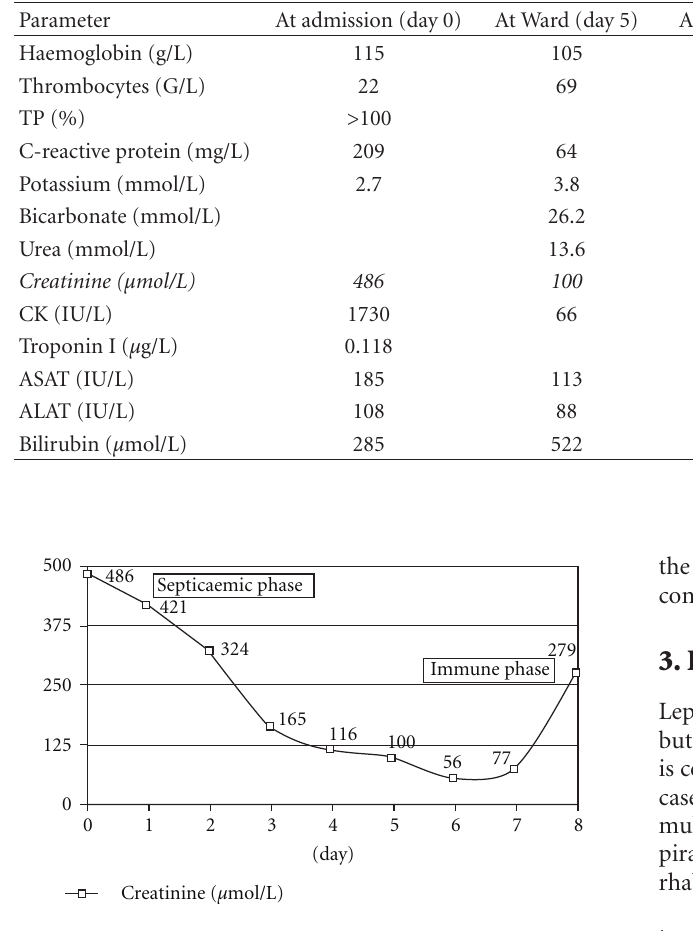
Figure 1: Evolution of creatinine mimicking the two phases of Weils